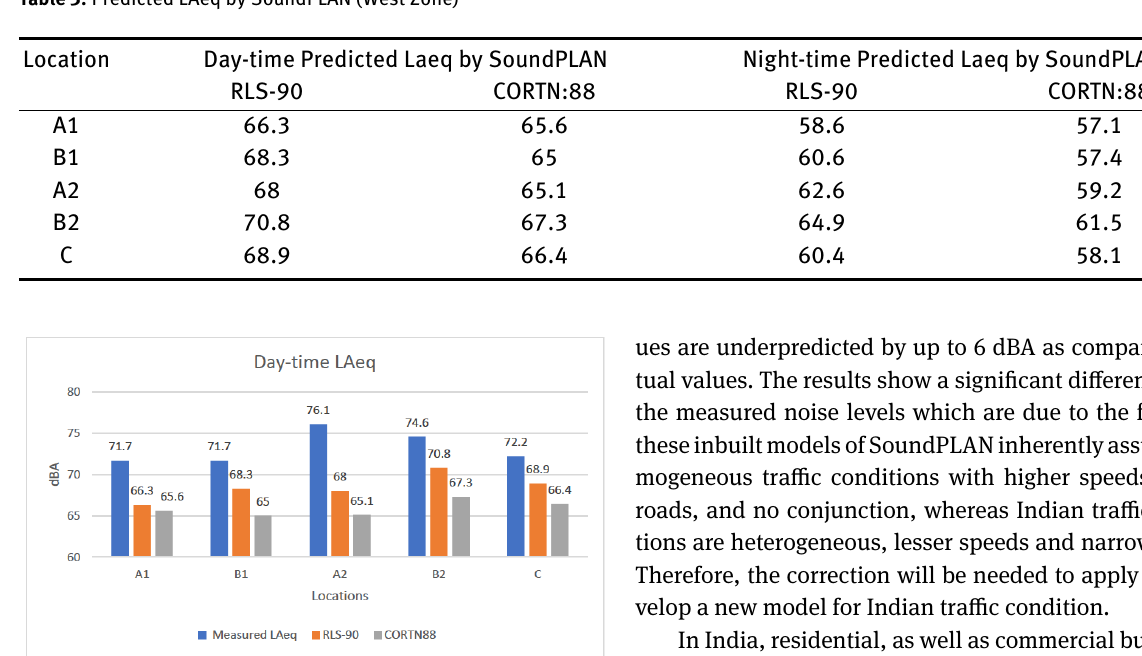
Table 3: Predicted LAeq by SoundPLAN (West Zone)